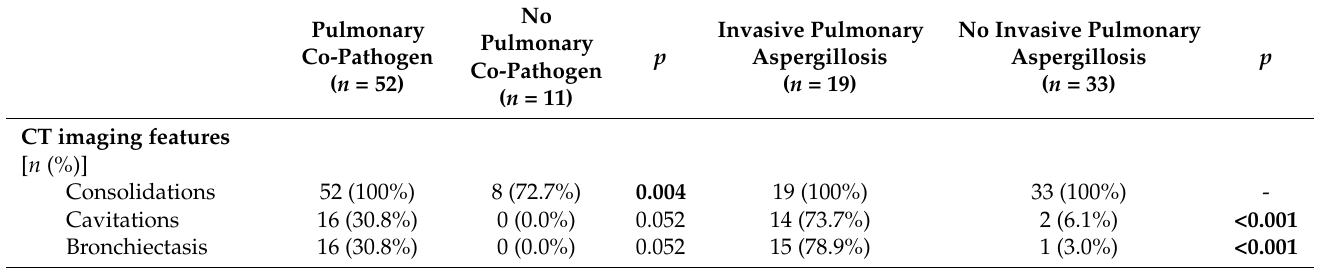
Figure 3. Axial HRCT images of a patient admitted to ICU with confirmed superinfection by Asper- gillus fumigatus showing pulmonary consolidations in the lower lobes complicated by bilateral cav- itations (white and black arrows in ( A )); Minimum Intensity Projection (MIP) reconstruction of the same patient demonstrating communication between the cavitations and the bronchial tree (white and black arrows in ( B )). Sagittal HRCT images of a patient admitted to ICU with confirmed super- infection by Aspergillus niger showing pulmonary consolidations in the anterior-basal segment of the right lower lobe complicated by small cavitations (black arrow in ( C )); Minimum Intensity Pro- jection (MIP) reconstruction of the same patient demonstrating communication between the cavita- tion and the bronchial tree (black arrows in ( D )).